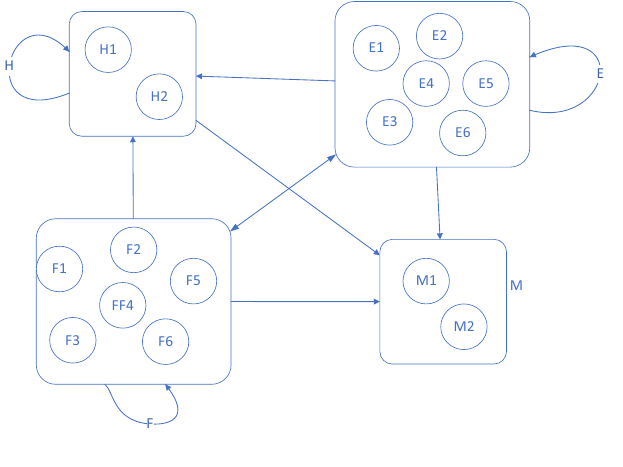
Figure 3. ANP model network layer